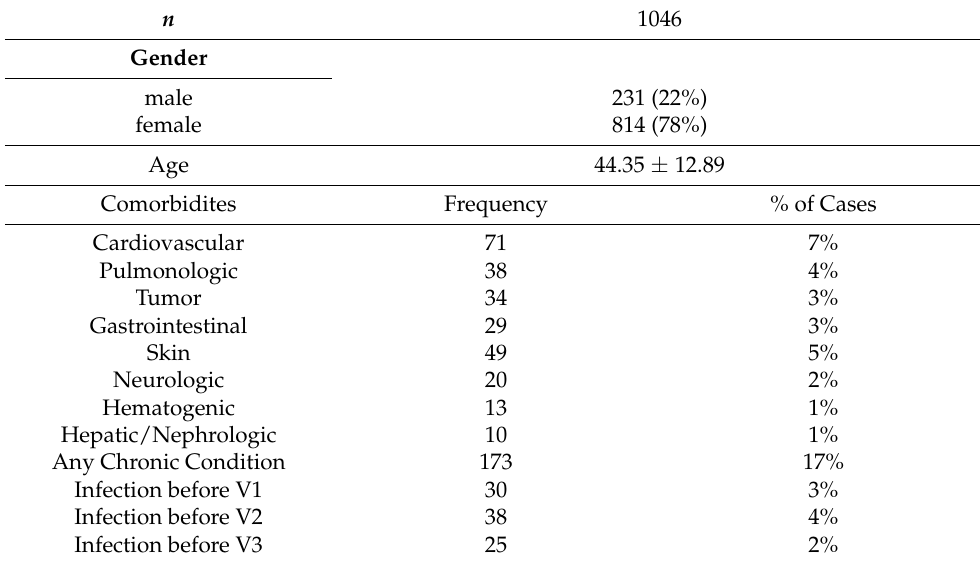
Table 1. General cohort